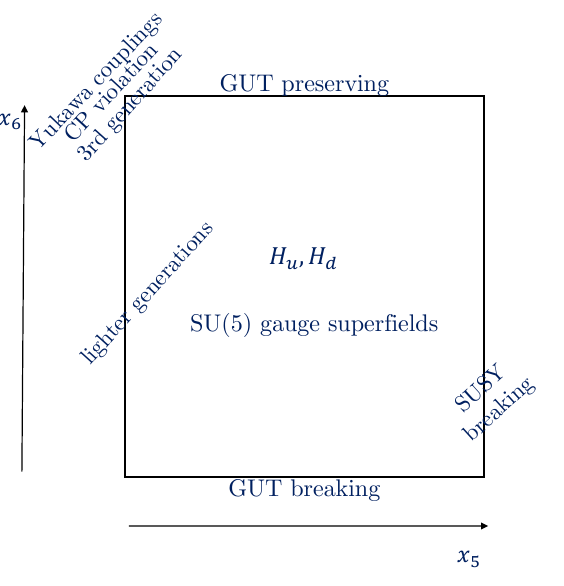
Figure 3 . Schematic picture of the six-dimensional structure incorporating unification, where only the two extra dimensions are shown. The x 5 direction enforces sequestering the SUSY breaking from SM matter fields, flavor-violation and CP-violation. The x 6 direction realizes orbifold grand- unification, its Kaluza-Klein scale setting the scale of gauge-coupling and b − τ